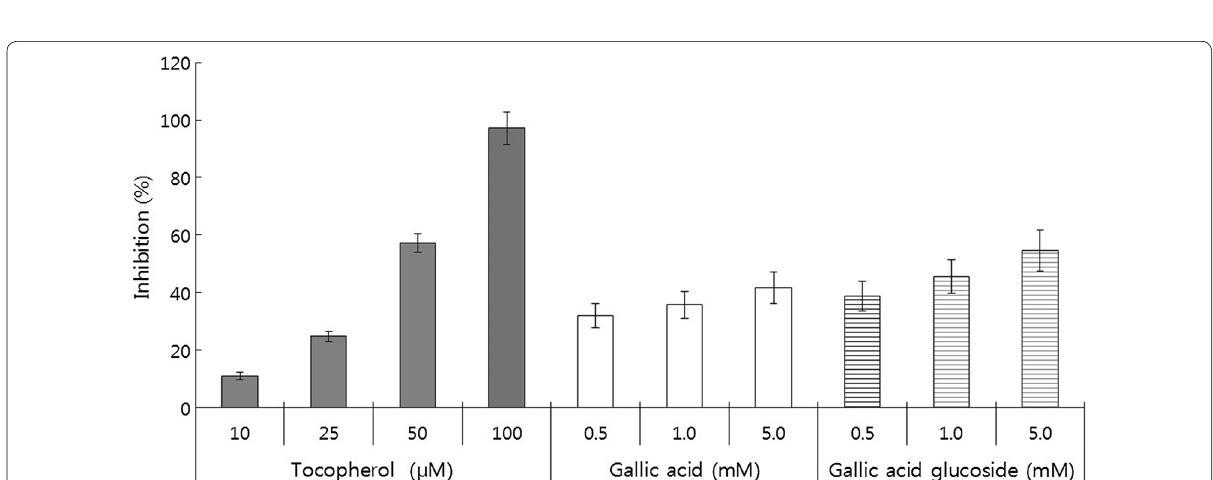
Fig. 4 The inhibition of lipid peroxidation by gallic acid and gallic acid glucoside. The measurement was performed by using ARA‑L kits obtained from ABCD GmbH and a chemiluminescence measuring device HP‑CLA (Tohoku, Japan). α‑Tocopherol (10, 25, 50, and 100 μM) was used as the control, and the extent of inhibition of lipid peroxidation by gallic acid and gallic acid glucoside (0.5, 1.0, and 5.0 mM) was